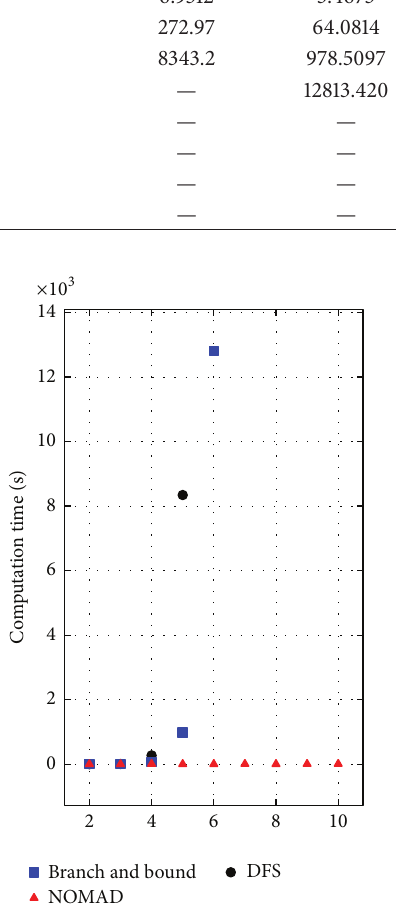
Figure 6: Scatter plot of execution times for